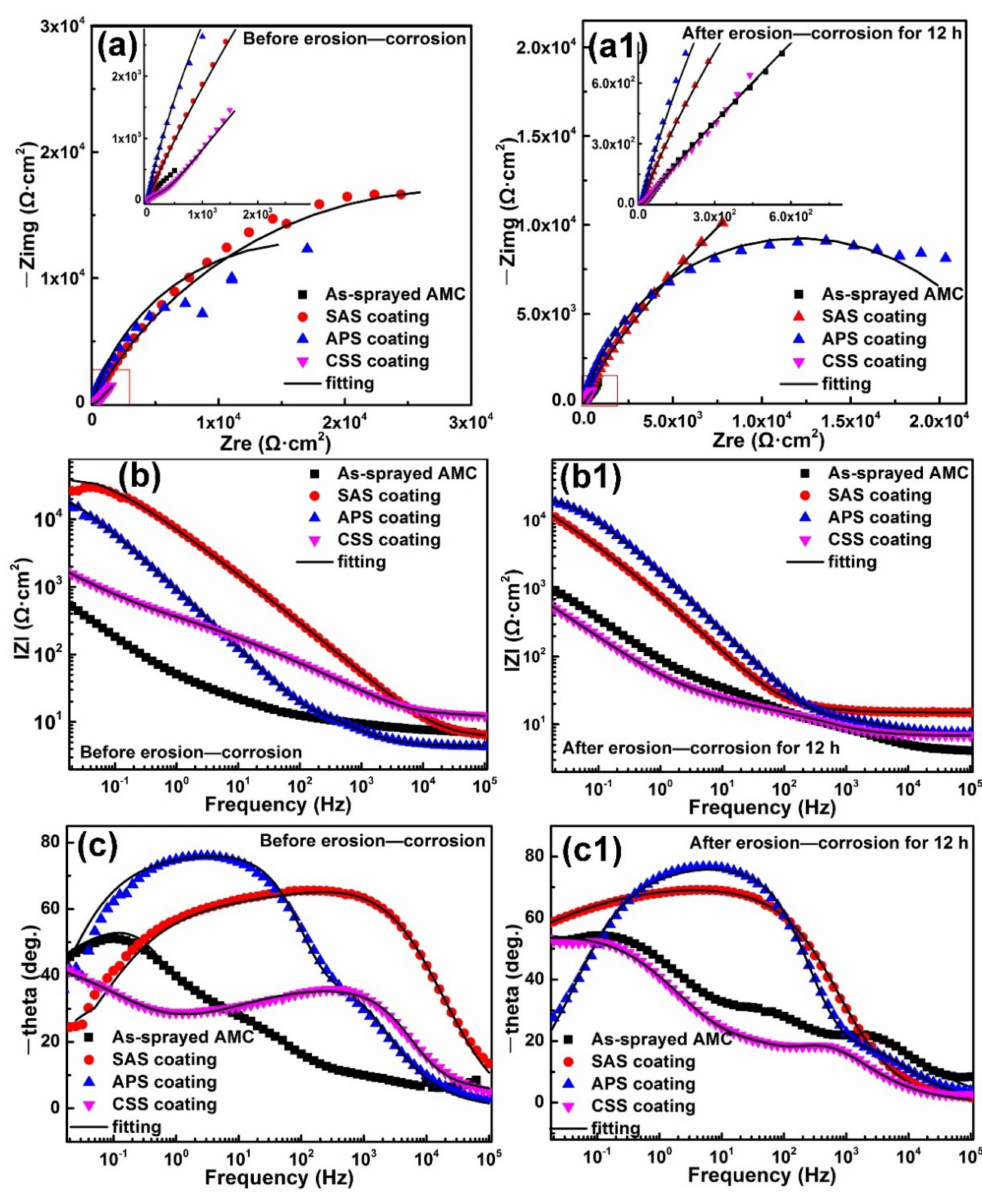
Figure 7. EIS plots of four coatings ( a – c ) before and ( a1 – c1 ) after erosion–corrosion tests for 12 h by 3.5 wt.% NaCl solution containing 2 wt.% sand. ( a , a1 ) Nyquist plots, ( b , b1 ) Bode impedance magnitude plots and ( c , c1 ) Bode phase angle